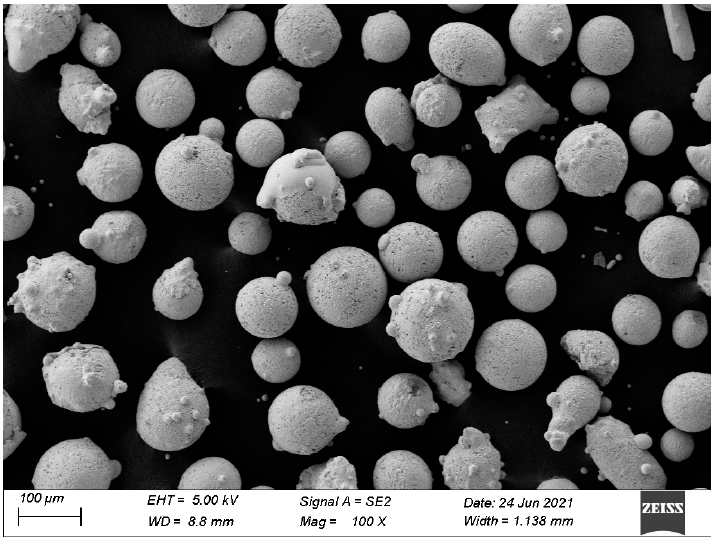
Figure 1. SEM image of Fe–Cr–Mo–Ni–B powder.